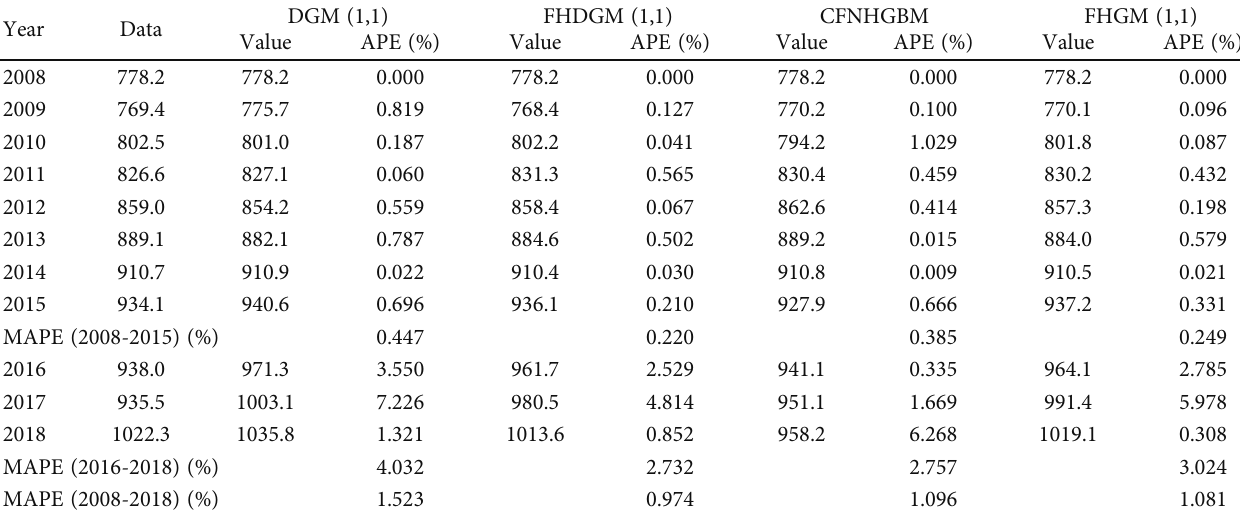
Table 3: Fitted and predicted values in natural gas consumption of North America.